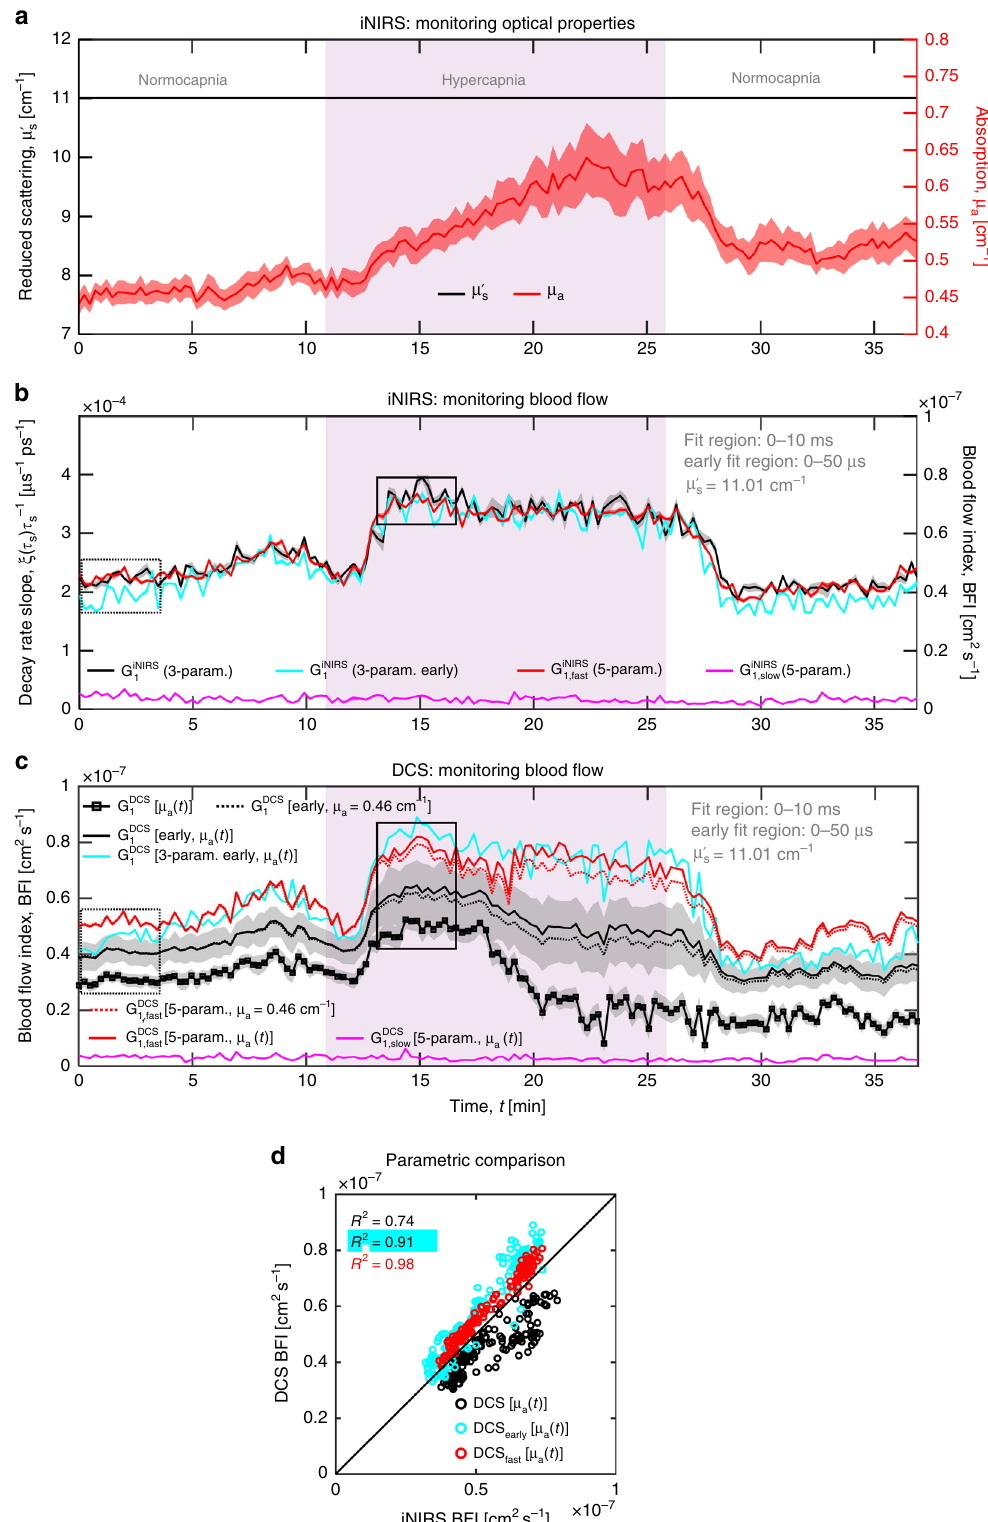
Fig. 7 iNIRS deconstructs DWS/DCS during a hypercapnic challenge in the mouse brain. By accounting for absorption changes ( a ), conveniently also measured by iNIRS, and fi tting early time lags in DWS/DCS, agreement of DWS/DCS blood fl ow indices with iNIRS is improved ( b – c ). However, even when such best practices are followed in DWS/DCS (black in d , the accuracy of DWS/DCS can still be signi fi cantly improved either by integrating just the iNIRS fast component (red in d ) or the iNIRS early time lag single exponential fi t (cyan in d ). This is likely because the slow component (magenta), though intravascular in origin, is not described by conventional DWS/DCS theory (Supplementary Fig.